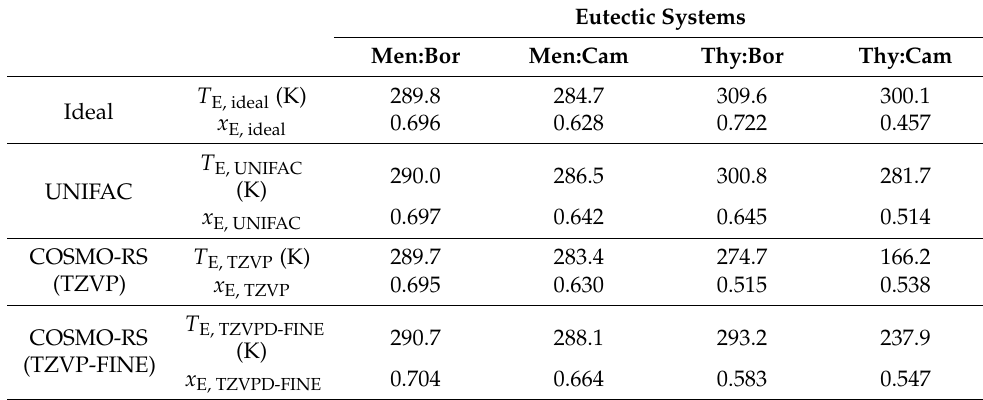
Figure 4. Measured SLE phase diagrams of the terpene-based solvent systems. Table 6. Predicted eutectic temperatures and molar ratios of the solvent systems